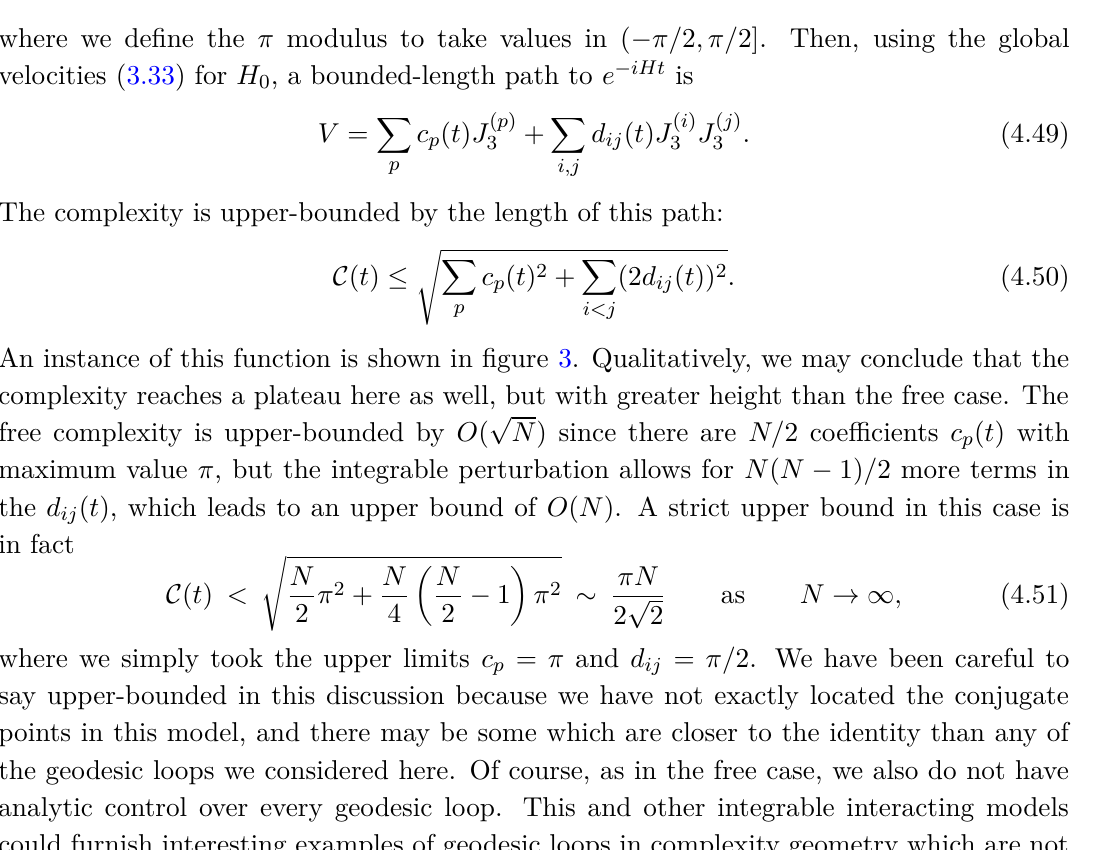
Figure 3 . Complexity bound (4.50) for an N = 20 instance of the integrable Hamiltonian (4.1) where (cid:15)M ij / 4 is drawn from the q = 4 SYK distribution with J = 1 . The initial sharp linear growth is due to the combined initial linear growth of both terms in (4.50), and the small fluctuations are due to the frequent geodesic loops in e − iH 0 t . The larger fluctuations, and the coarse-grained shape of the function itself, are controlled by the geodesic loops in e − i(cid:15)H 1 t that we have included in defining d ij ( t ) . The plateau is clearly O ( N ) ; its height without the integrable perturbation would √ be less than the height of the initial sharp rise, which is at most O ( N )